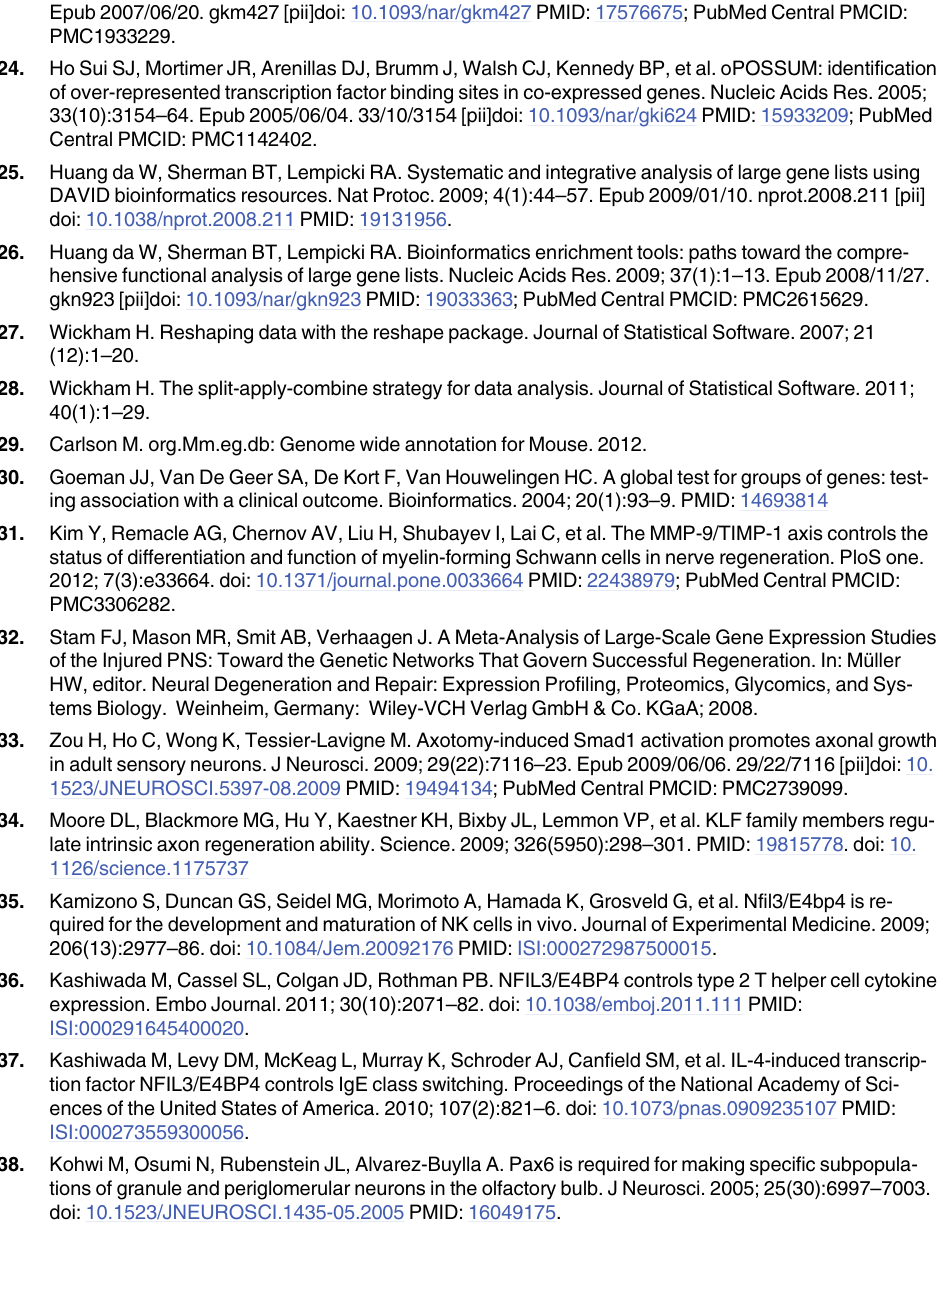
PLOS ONE | DOI:10.1371/journal.pone.0127163 May 20,